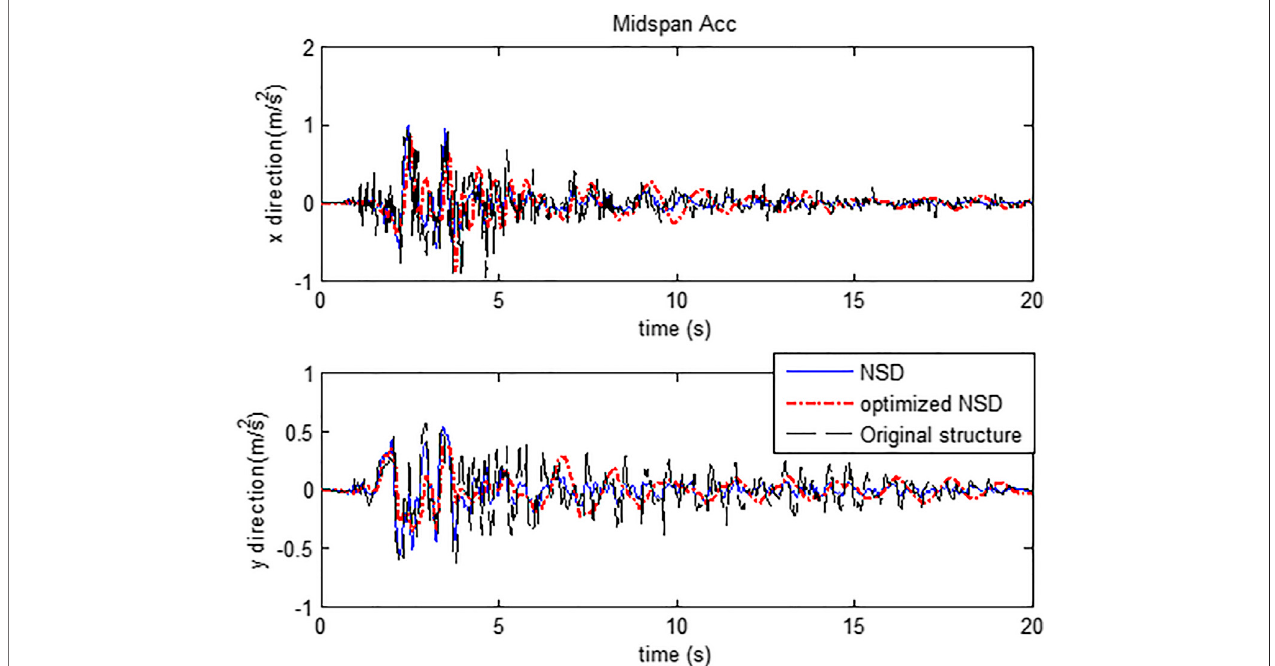
FIGURE 7 | Time history of acceleration responses at mid-span under NPalmspr earthquake.